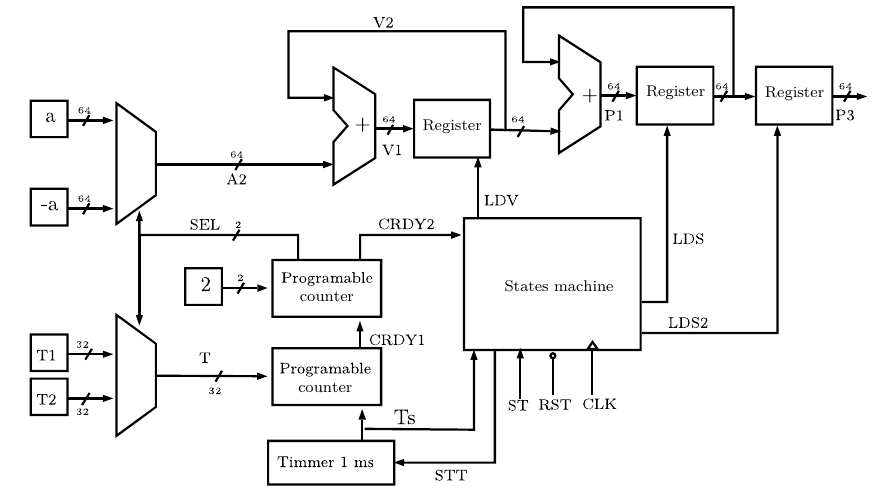
Figure 6. Block diagram of the discrete trapezoidal